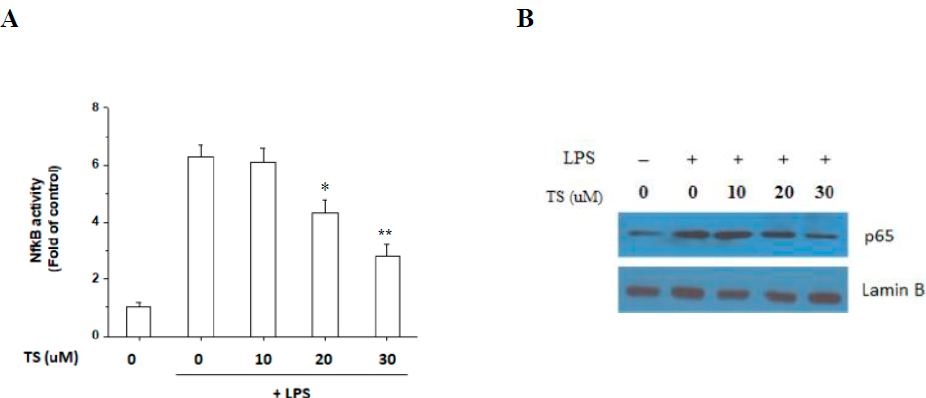
Figure 6. Suppression of nuclear factor κ B (NF- κ B) activation in LPS-stimulated RAW 264.7 cells. ( A